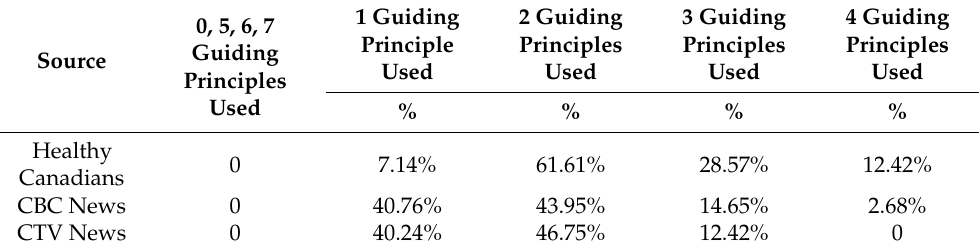
Table 4. Percentage of Facebook posts combing seven guiding principles for Healthy Canadians, CBC News, and CTV